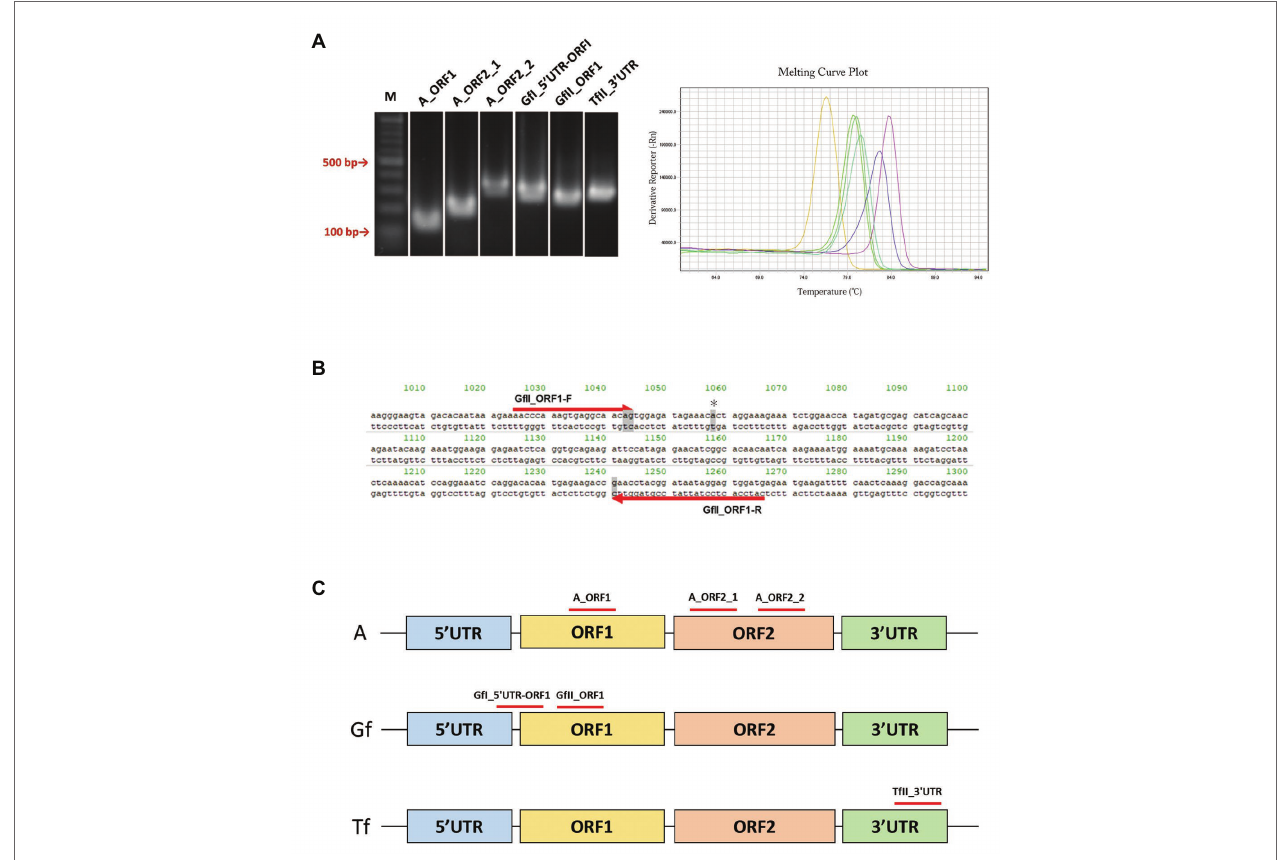
FIGURE 1 | PCR primer pairs specific for individual active long interspersed nuclear element-1 (LINE-1) subfamilies. (A) Agarose gel electrophoresis of PCR products, left . Melting curve analysis of PCR products in the quantitative PCR (qPCR) context, right . M, molecular size markers. (B) Sequences of the GfII_ORF1 primer pair. Primer sequences aligned with the consensus sequence of GfII are shown. The unique sequence in GfII is highlighted in gray. * Indicates the unique sequence used for sequencing analysis of PCR products. (C) Location of the validated primer pairs. Monomer sequencers are omitted from the